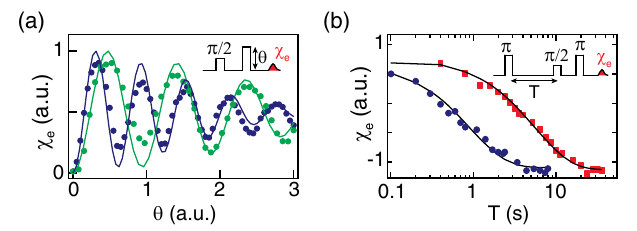
FIG. 8. (a) Measured (symbols) and numerically simulated (lines) Rabi oscillations at transitions i ¼ 1 (blue) and i ¼ 4 (green) with Res1. (b) Measured spin-energy relaxation with inversion recovery sequence for the transitions i ¼ 1 (circles) and CT (squares). Lines are best fits yielding T 1 of 1 (cid:3) 0 . 2 s and 5 . 5 (cid:3) 1 s, respectively. The resonator loss rate κ at CT is 30% larger than the first transition due to magnetic-field-induced vortices.